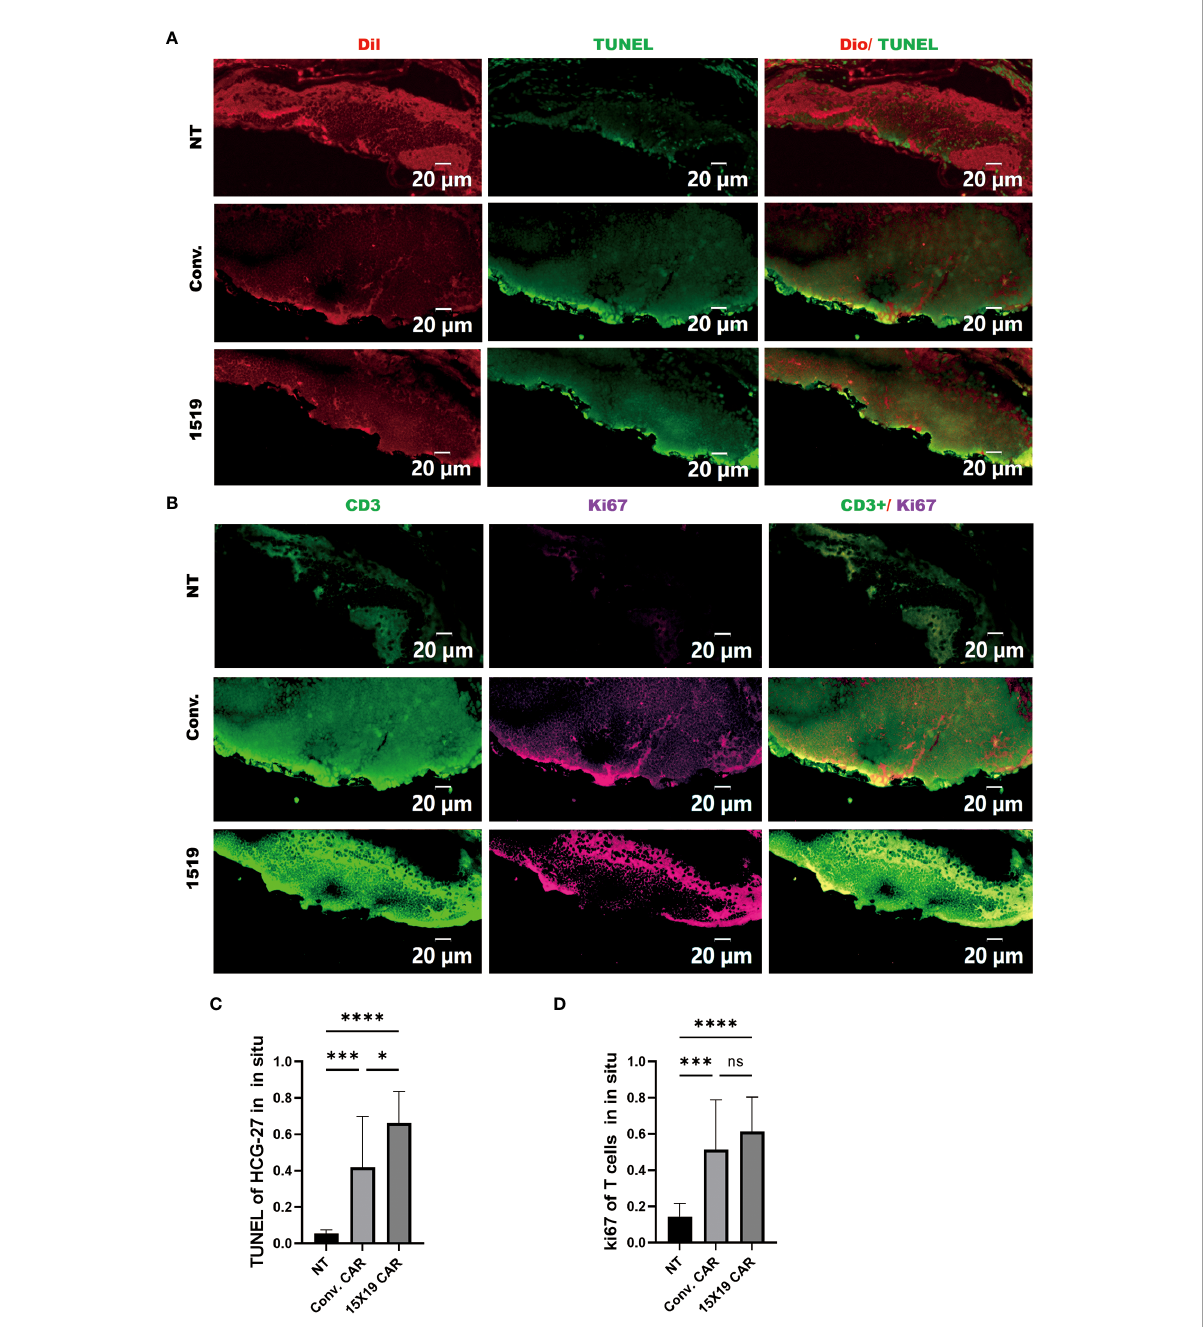
FIGURE 8 Proliferation of transplanted T cells and tumor apoptosis in situ in Zebra fi sh. Zebra fi sh were frozen and serially sectioned, and TUNEL immuno fl uorescence was used to detect tumor apoptosis, and Ki67 to detect T cell proliferation. (A) , Representative images of tumor apoptosis (TUNEL : DIO); (B) representative images of proliferating T cells (Ki-67:CD3); (C) percentage of TUNEL-positive cells in HCG-27 cells; (D) , percentage of Ki-67-positive cells in T cells. Data are representative images of > 3 independent, reproducible experiments. Statistical signi fi cance analysis was performed using one-way ANOVA and multiple comparison tests. ns, Differences are not signi fi cant;*p < 0.05;***p < 0.001;****p < 0.0001, scale bar = 25 m